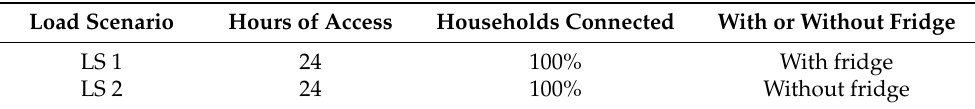
Table 3. Comparison of monthly income and electricity cost in Pangan-an. 2015 [59] vs. 2018 (sur- veyed) Attribute Average Std. Min. Max.